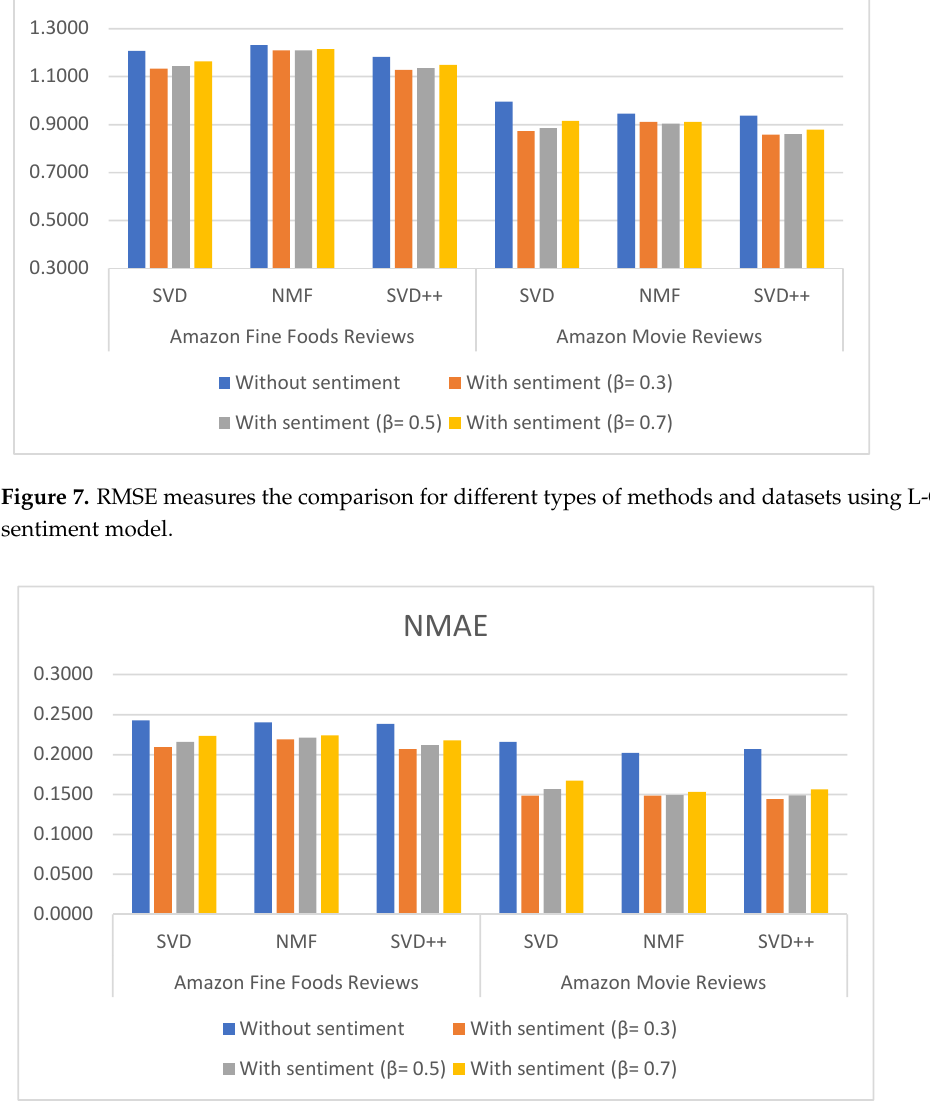
Figure 8. NMAE measures the comparison for different types of methods and datasets using L-CNN sentiment model.